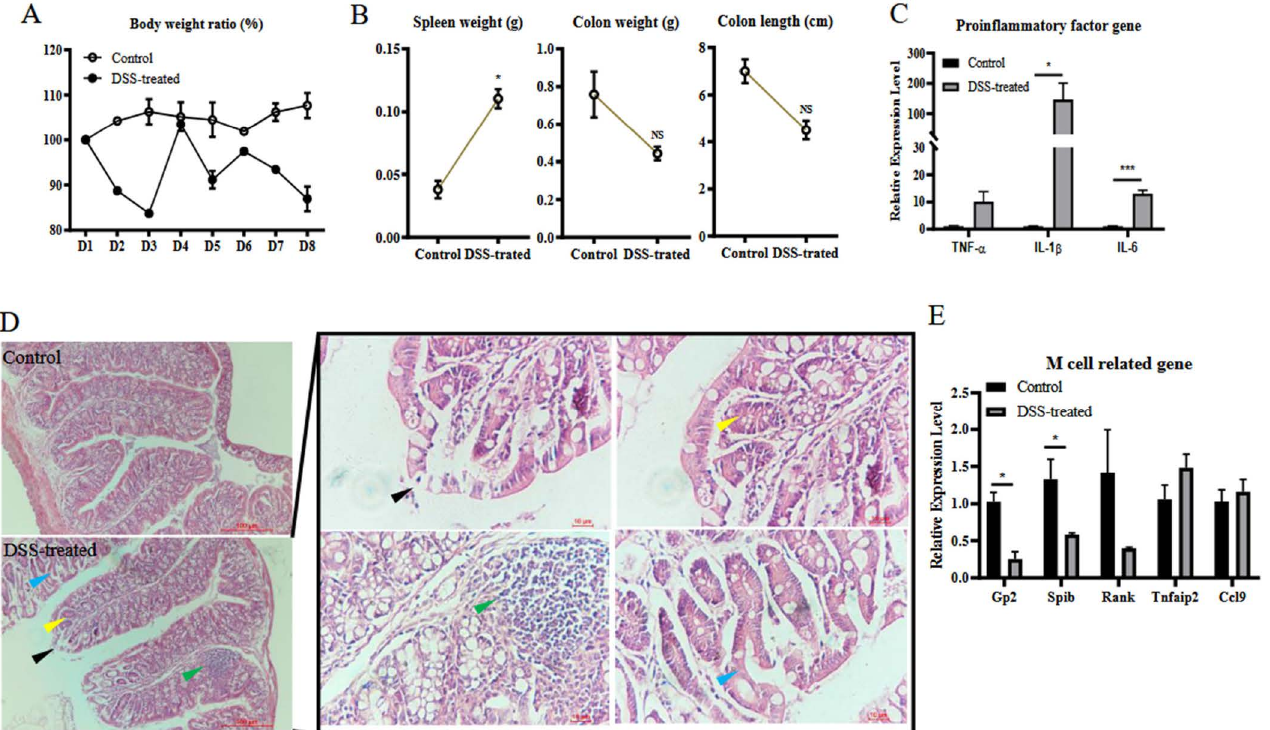
Figure 4. MyD88 is involved in colitis induced M cell differentiation. MyD88 − / − mice in the DSS- treated group ( n = 3) and control group ( n = 3) were allowed to intake DSS-contained or normal water for 7 days freely. The body weight of mice was monitored daily ( A ). The mice were sacrificed on day 8, and their spleen weight, colon weight, and colon length were measured to assess the pathological changes caused by DSS treatment ( B ). Total RNA from colon samples was used to detect the mRNA levels of TNF- α , IL-1 β , IL-6 by RT-qPCR ( C ). Tissue samples from the colon were used for histological analysis to evaluate their colitis ( D ). Total RNA from colon samples was used to detect the mRNA levels of GP2, Spi-B, RANK, Tnfaip2, and CCL9 by RT-qPCR ( E ). The data were calculated using the 2 − ∆∆ Ct method. In all graphs, data are shown as ‘mean ± SEM’. Results were designated with: NS, p > 0.05; * p < 0.05; *** p <